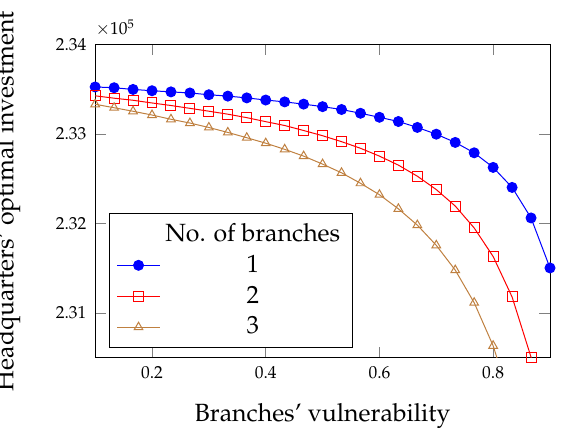
Figure 10. Optimal investment for the headquarters in the limited liability case.